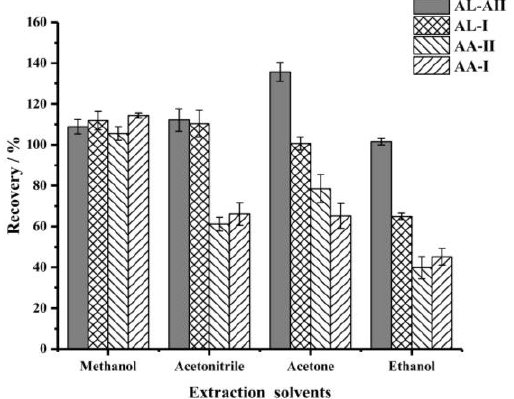
Figure 2. The effect of extraction solvents (volume of extraction solvent, 20 mL; extraction time, 30 min).